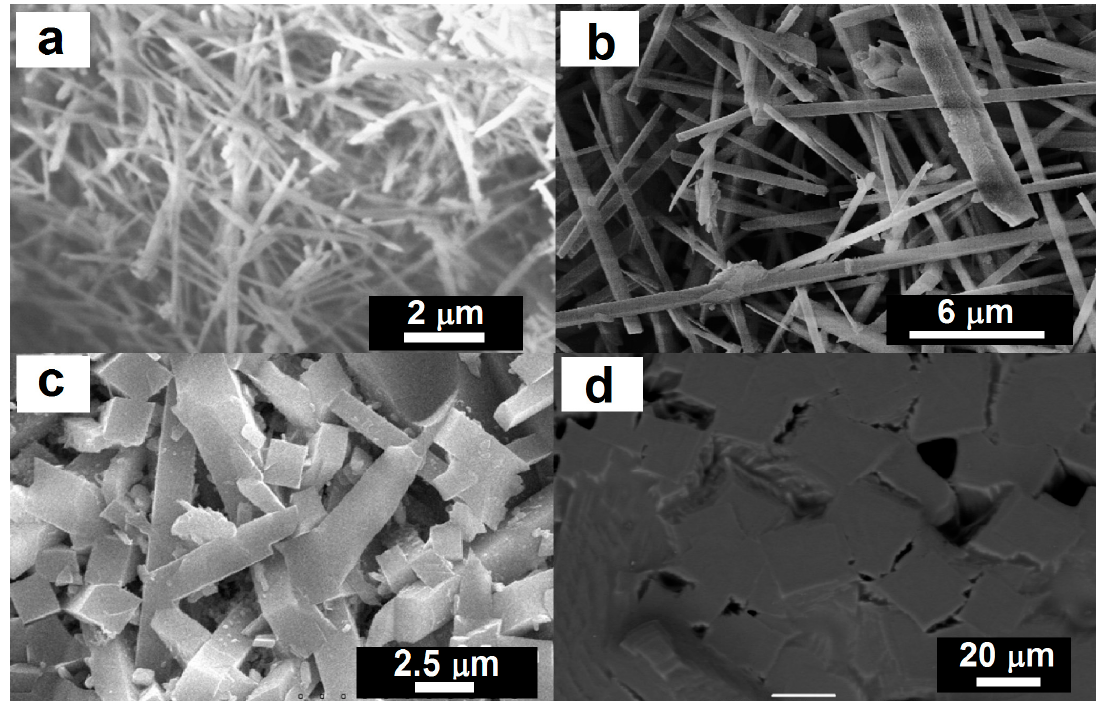
Figure 1. SEM microphotographs of various aspect ratios of mullite crystals produced using coal fly ash ( a ) Aspect ratio of >25. Reprinted with permission from [14] (Copyright (2011) Elsevier). ( b ) Aspect ratio of >30. Reprinted with permission from [15] (Copyright (2007) Elsevier). ( c ) Aspect ratio of 6. Reprinted with permission from [17] (Copyright (2009) Elsevier). ( d ) Aspect ratio of 1. Reprinted with permission from [22] (Copyright (2011) Elsevier).